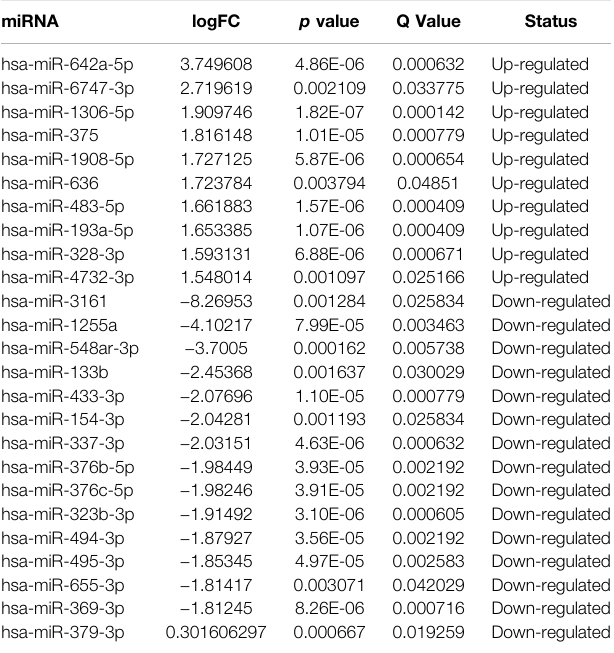
TABLE 5 | Top 10 signi fi cantly upregulated and 15 downregulated miRNA between groups.